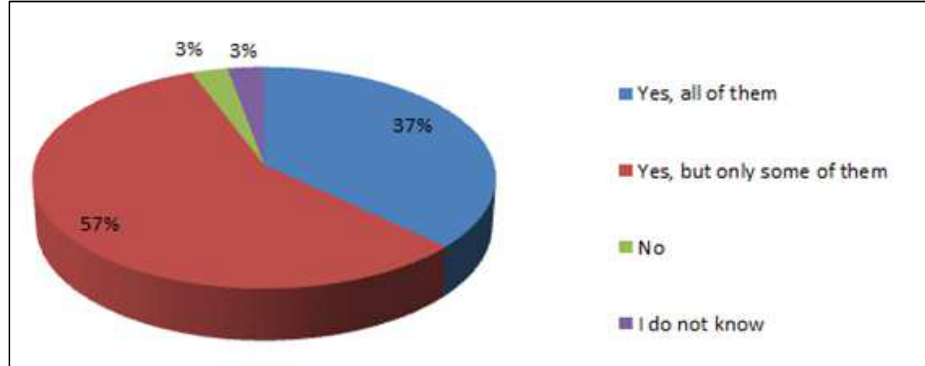
Fig. 9 Results of question 10: Did you carry out any actions suggested to you by trainers?